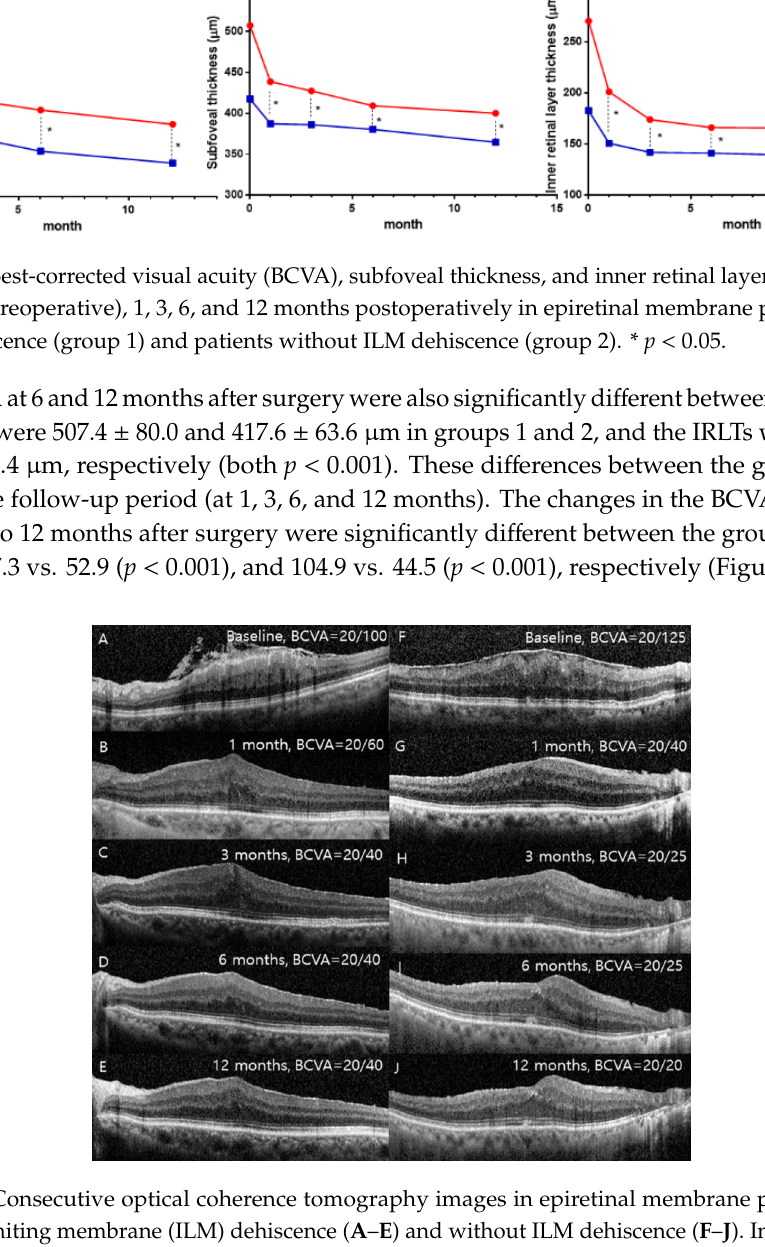
Table 2. Changes in visual acuity, subfoveal thickness, and inner retinal layer thickness after surgery. Group 1, patients with an internal limiting membrane tear; group 2, patients without an internal limiting membrane tear. BCVA, best-corrected visual acuity; SFT, subfoveal thickness; IRLT, inner retinal layer thickness. * p -values for BCVA differences; † p -values for SFT differences; ‡ p -values for IRLT differences. Values in boldface ( p < 0.050) are statistically significant.